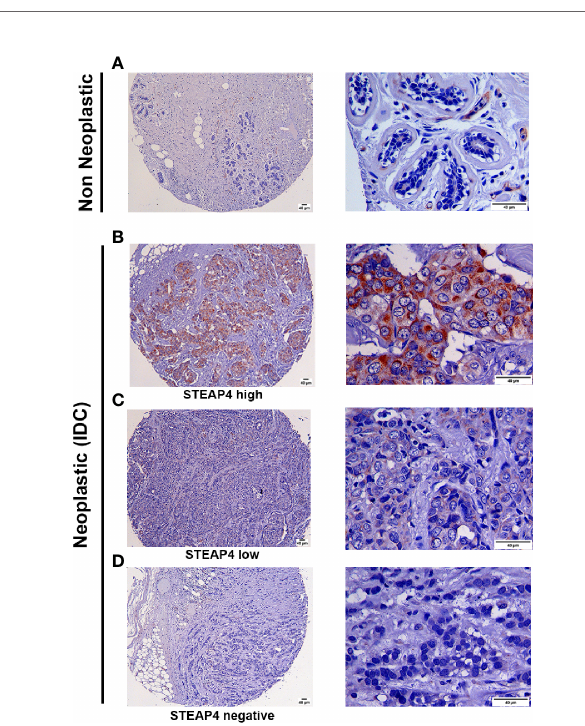
FIGURE 4 | Immunohistochemical analysis of STEAP4 expression in human BC tissues. STEAP4 expression was assessed in 2 independent tissue microarray (TMA) slides, containing 6 cases of invasive ductal carcinoma and adjacent normal breast tissue (BR251c) and 36 cases of breast cancers and 12 cases of normal and benign breast tissues (BRC961). Representative IHC images (100x and 400x magni fi cations, scale bars = 40 m m) of (A) negative STEAP4 expression in a non-neoplastic breast tissue, (B) high STEAP4 expression, in an invasive ductal carcinoma, (C) low STEAP4 expression in an invasive ductal carcinoma and (D) negative STEAP4 expression in an invasive ductal carcinoma from the TMAs are depicted.